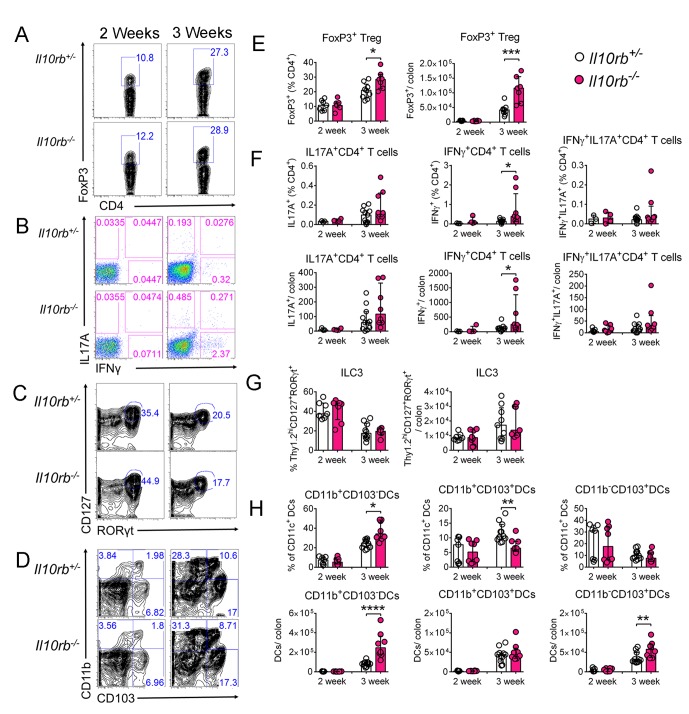
Minimal alterations in colonic lymphocytes and dendritic cells occur in the absence of IL10Rβ signaling in 3–4 week old mice.Representative FACS plots of (A) FoxP3+ Tregs, gated on CD45+CD3e+CD4+ T cells, (B) CD4+ Th effectors following PMA and ionomycin stimulation for 4.5 hr, gated on CD45+CD3e+CD4+ T cells, (C) Type three innate lymphoid cells (ILC3), gated on CD3e-CD45loThy1.2hi cells, and (D) DCs, gated on CD45+CD11c+ cells in the LP of 2 and 3–4 week old Il10rb-/- and littermate Il10rb+/- controls. Comparison of the frequencies and absolute numbers per colon of (E) FoxP3+ Tregs, (F) CD4+ Th effectors, (G) ILC3s, and (H) DCs is shown for Il10rb-/- vs control Il10rb+/- mice at 2 and 3–4 weeks of age. Results are pooled from 2 to 3 litters leading to 7–11 mice in each group. *p<0.05, **p<0.01, ***p<0.001, ****p<0.0001, Mann-Whitney U test. Data represents Median with IQR.